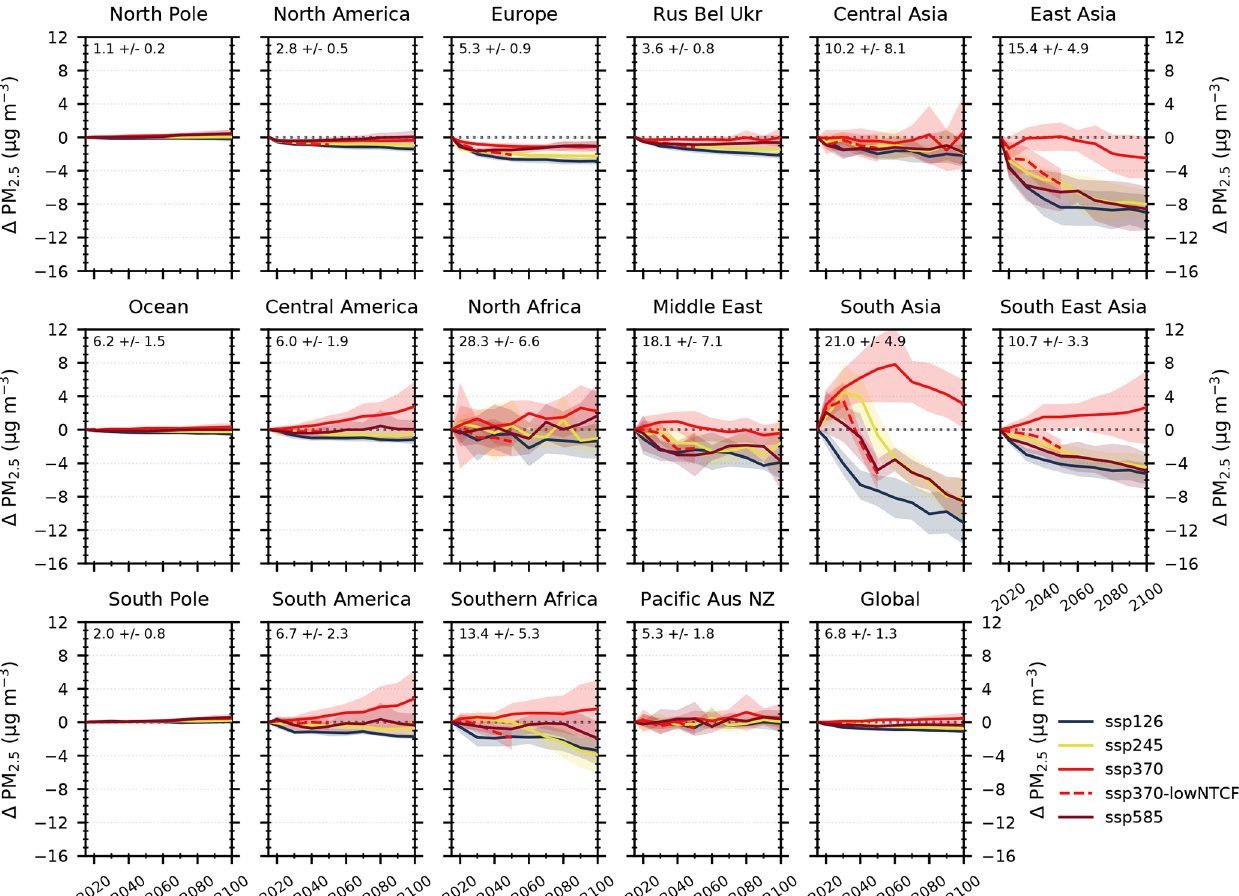
Figure 14. Future global and regional changes in annual mean surface PM 2 . 5 , relative to 2005–2014 mean, for the different SSPs used in CMIP6. Each line represents a multi-model mean across the region, with shading representing the ± 1SD of the mean. See Table 1 for details of models contributing to each scenario. The multi-model regional mean value ( ± 1SD) for the years 2005–2014 is shown in the top left corner of each